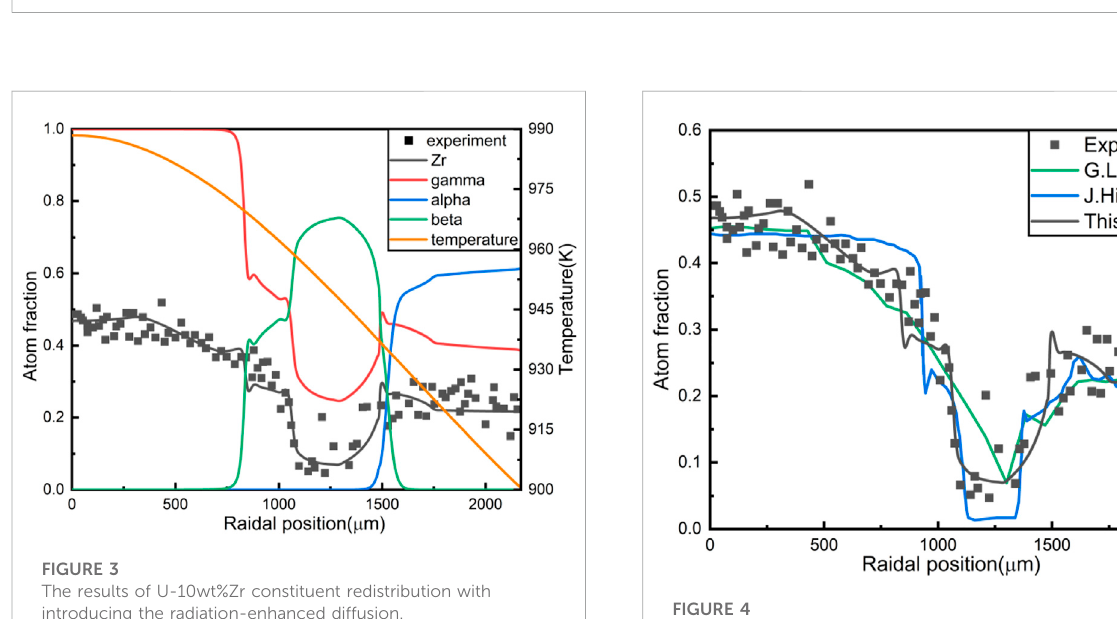
FIGURE 2 The results of U-10wt%Zr constituent redistribution without the effect of irradiation.